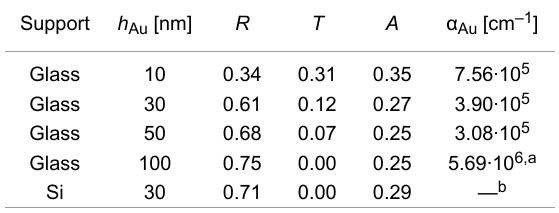
Table 1: Optical properties of Au-coated substrates at λ = 532 nm.